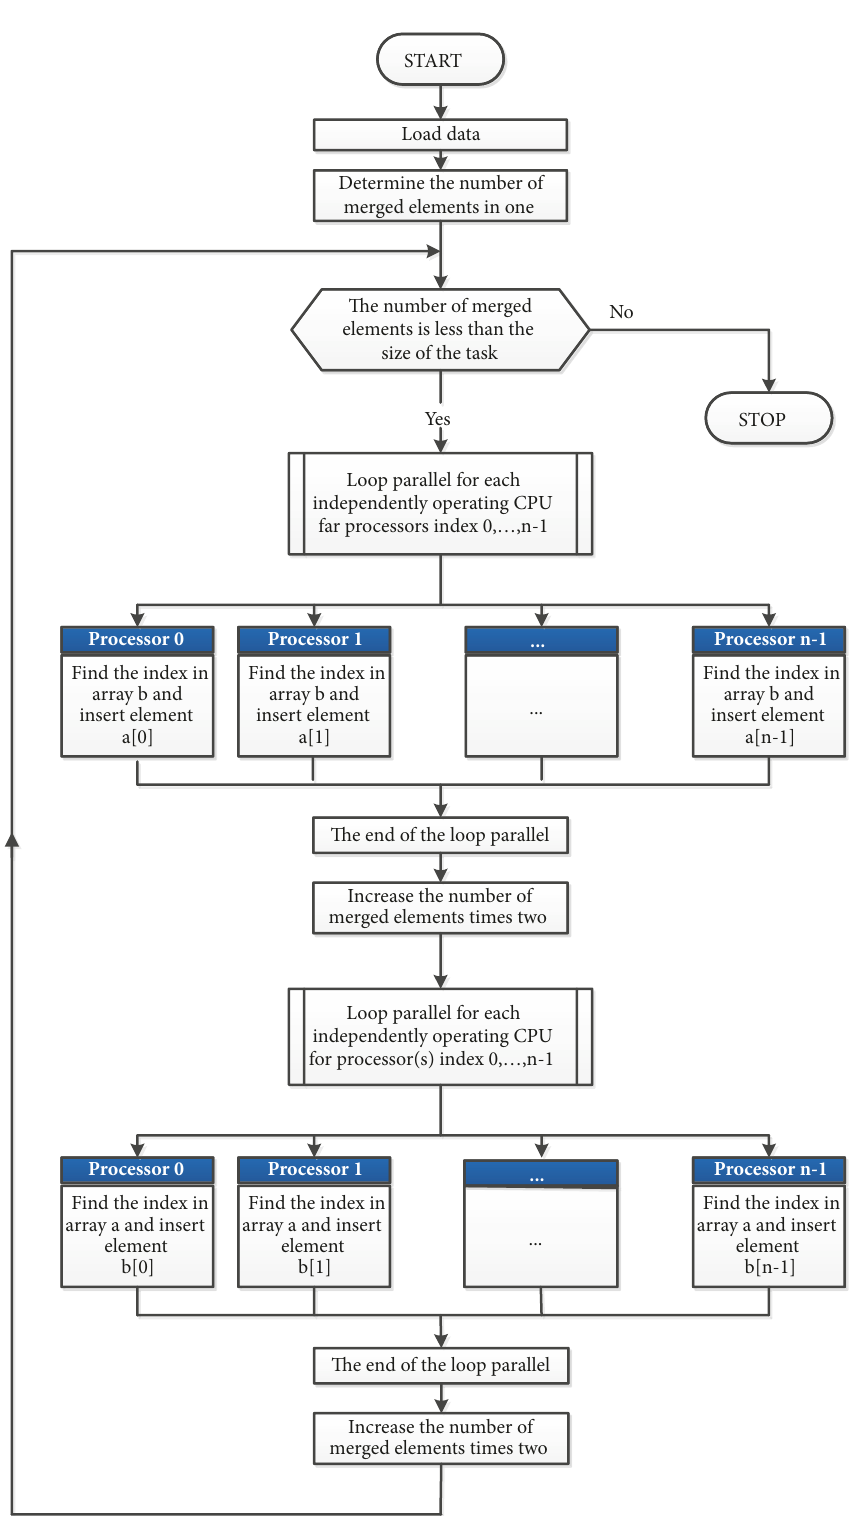
Figure 2: The block diagram of iterative task assignment to the processors while implementing proposed flexible algorithm that adapts to the number of used